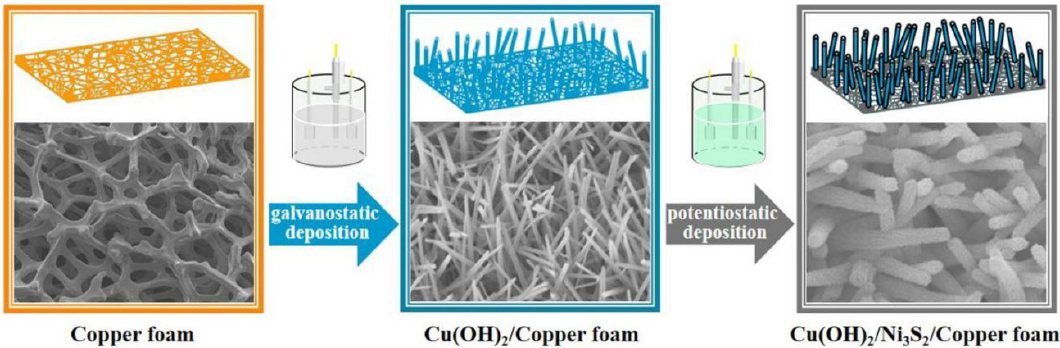
Figure 1. Schematic preparation of Cu(OH) 2 /Ni 3 S 2 electrode.